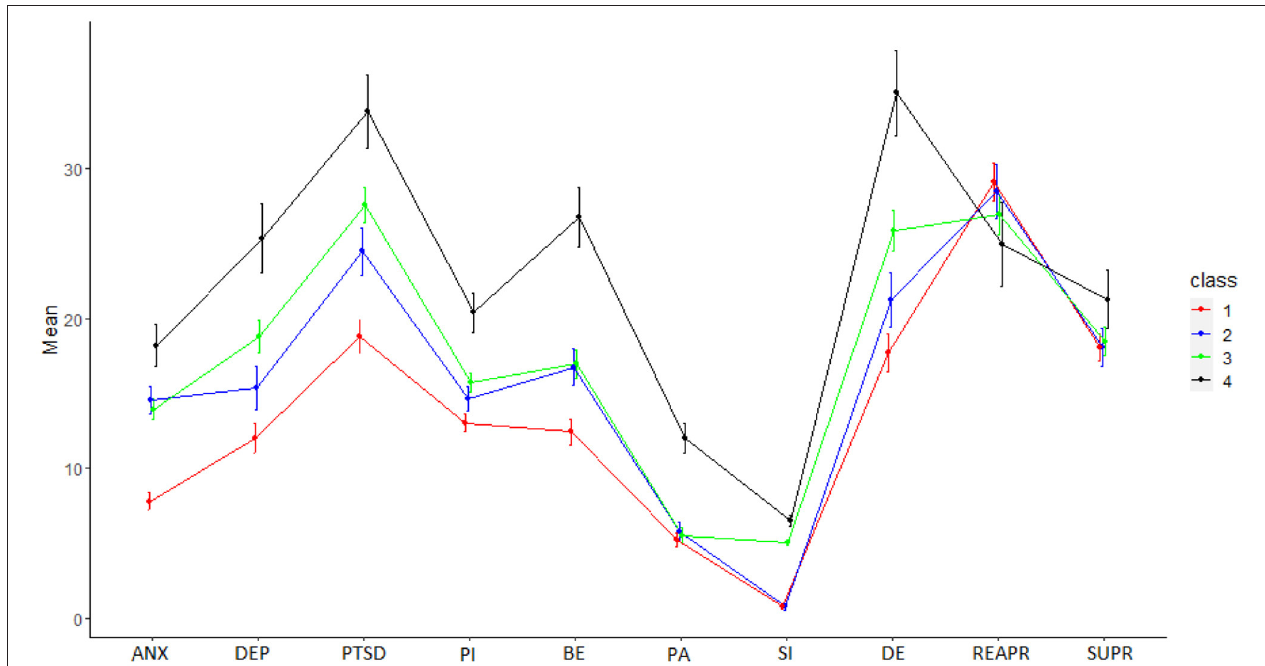
FIGURE 1 | Latent Profile Analysis (LPA): Four latent profile solutions. ANX, Anxiety; DEP, Depression; PTSD, Post Traumatic Stress Disorder; PI, Paranoid Ideation; BE, Bizarre Experiences; PA, Perceptual Anomalies; SI, Suicidal Ideation; DE, Defeat and Entrapment; REAPR, cognitive reappraisal; SUPR emotional suppression.